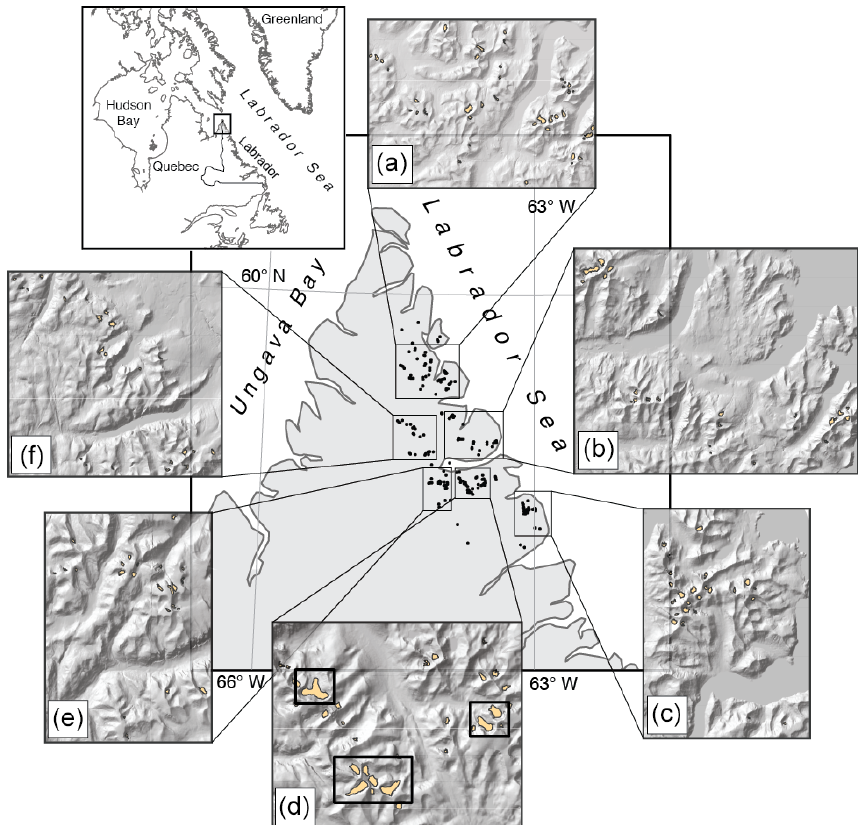
Figure 1. Locations (dots in main map) and outlines of Torngat Mountain glaciers, Labrador, Canada (upper left inset). Local glacier populations include (a) Four Peaks/Ryan’s Bay; (b) Mount Tetragona/Mount Eliot/Razorback Mountain; (c) Blow Me Downs; (d) Selamiut Range/Cirque Mountain; (e) Tallek Arm; and (f) Komaktorvik Lakes. Inset map shaded relief elevations are derived from ASTER Global DEM data. Outlines in (d) refer to glacier locations in Fig. 2.